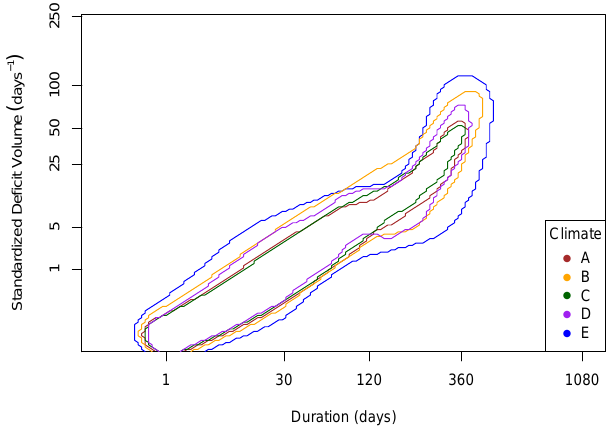
Fig. 4. 90% bivariate probability fields of hydrological drought du- ration and standardized deficit volume for the five K¨oppen–Geiger major climate types (A–E) for the reference situation (i.e., a medium soil water supply capacity (Soil II) and intermediately responding groundwater system ( j = 250 d)). We used the double square root of the drought duration because of the wide spread of the durations (the kernel smoothing, Sect. 2.2, allows drought durations smaller than one